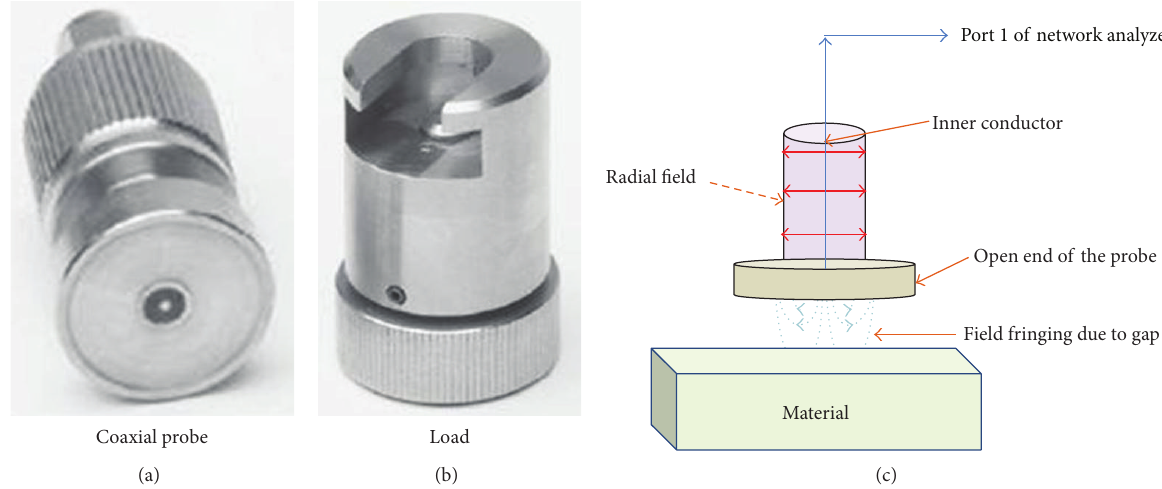
Figure 2: Equipment and setup for the measurement of dielectric properties of the two samples. (a) Cylindrical, open-ended, and coaxial probe [26]. (b) Load for the calibration of the open-ended probe [26]. (c) Schematics of the experimental setup, showing field infringement at the open end of the probe due to abrupt change in impedance.